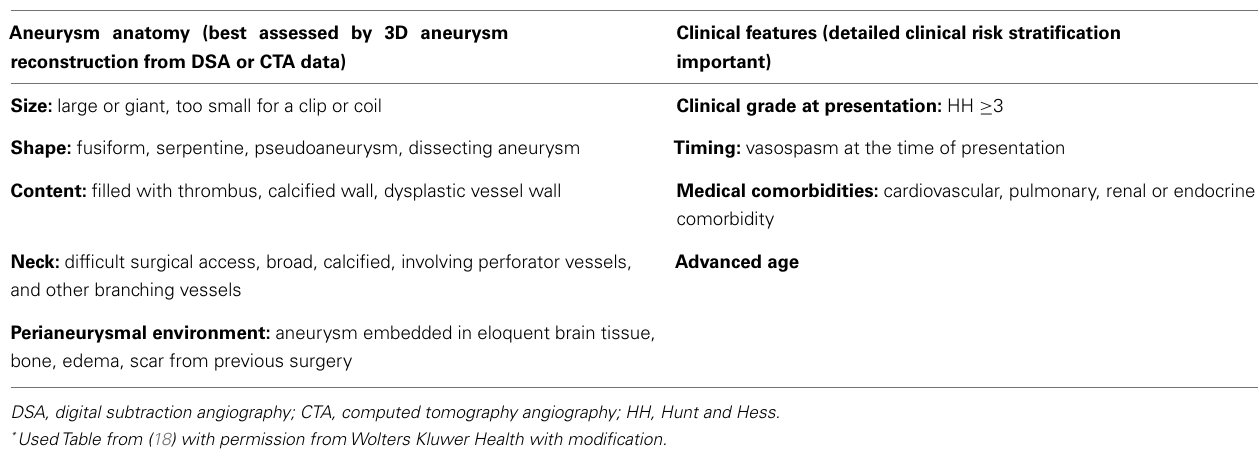
Table 1 | Features contributing to complex aneurysms *